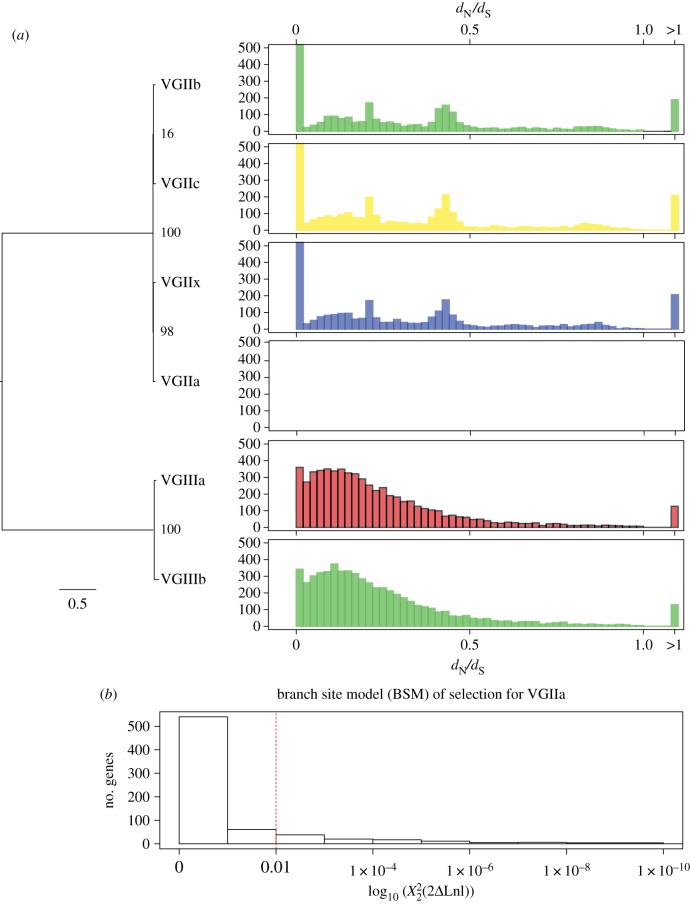
Phylogenetic relationships and selection of the C. gattii clonal subclades. (a) A RAxML tree with the GTRCAT model and 1000 bootstrap replicates next to a histogram showing the number of genes with binned dN/dS (ω) values. (b) Histogram of 714 genes with  values from the branch site model (BSM) of selection in PAML. The remaining genes did not have values (e.g. owing to insufficient genetic distance). The dashed red line is at q = 0.01, which we have used as a cut-off for significance. (Online version in colour.)